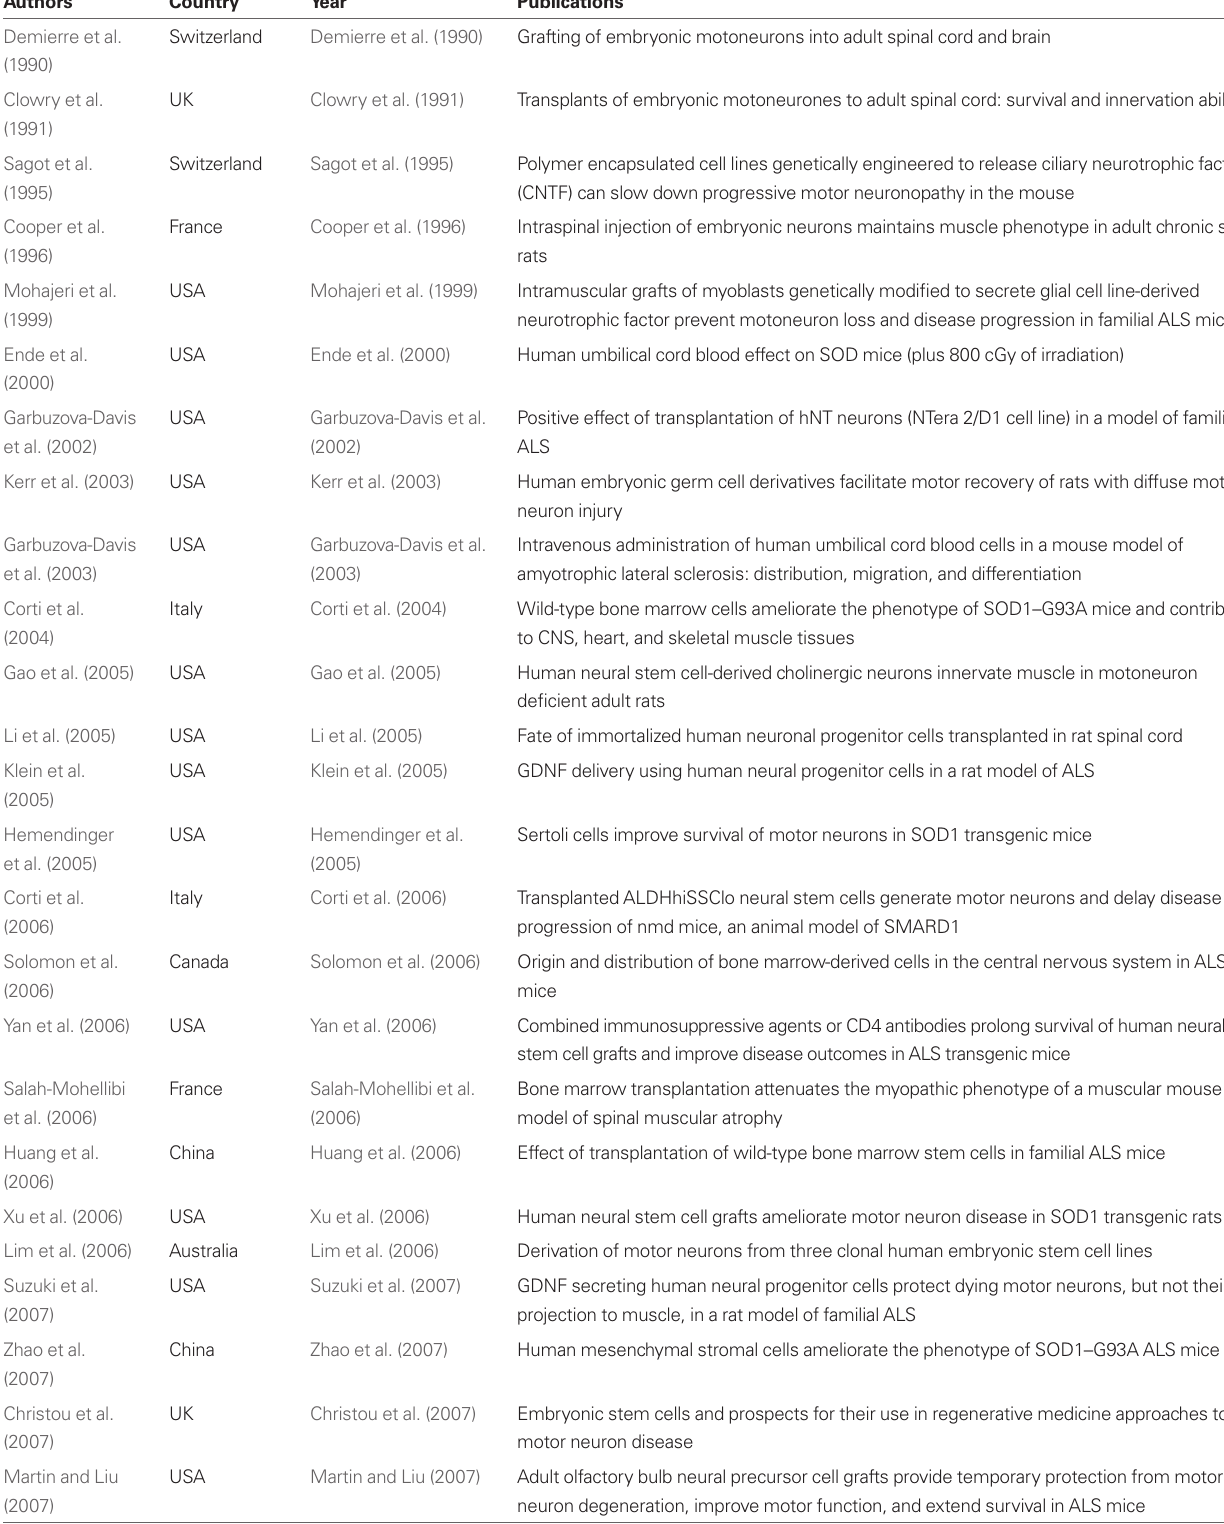
Table 1 | Selected preclinical literatures of cell-based therapy for ALS (data from Pubmed; modified from 5).